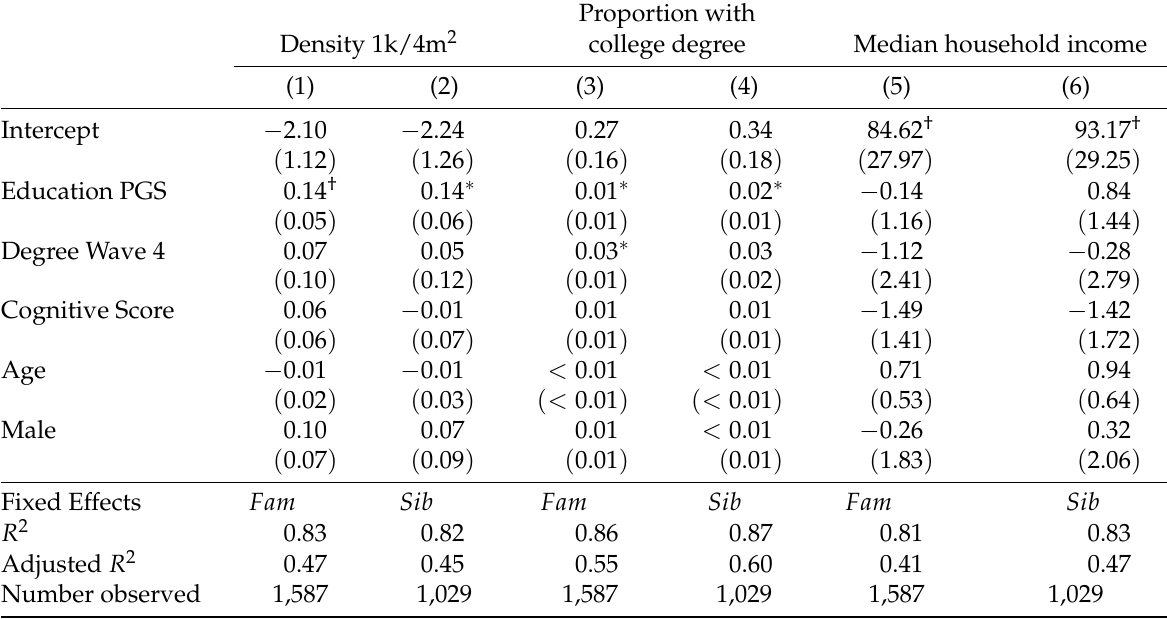
Table 2: Wave 4 neighborhood attainments; family and sibling fixed-effects